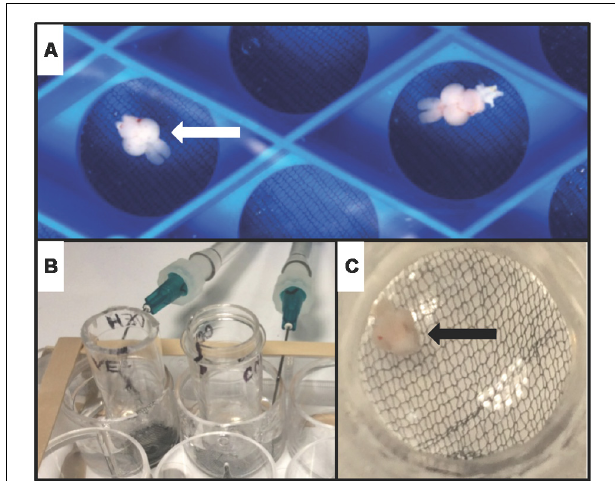
FIGURE 1 | Whole-brain ex vivo zebrafish treatment assay. (A) Whole brains from adult zebrafish (arrowhead) were removed, and allowed to recover in oxygenated artificial cerebrospinal fluid (aCSF)-filled chambers. (B) During treatment, brains were transferred to custom-made treatment chambers inserted into wells of a 12-well tissue culture plate containing vehicle (aCSF) or aCSF plus carbachol (CCh). 95% oxygen and 5% carbon dioxide were delivered to each well via a 14G needle. (C) View of a single brain (arrowhead) suspended on mesh at the base of a treatment